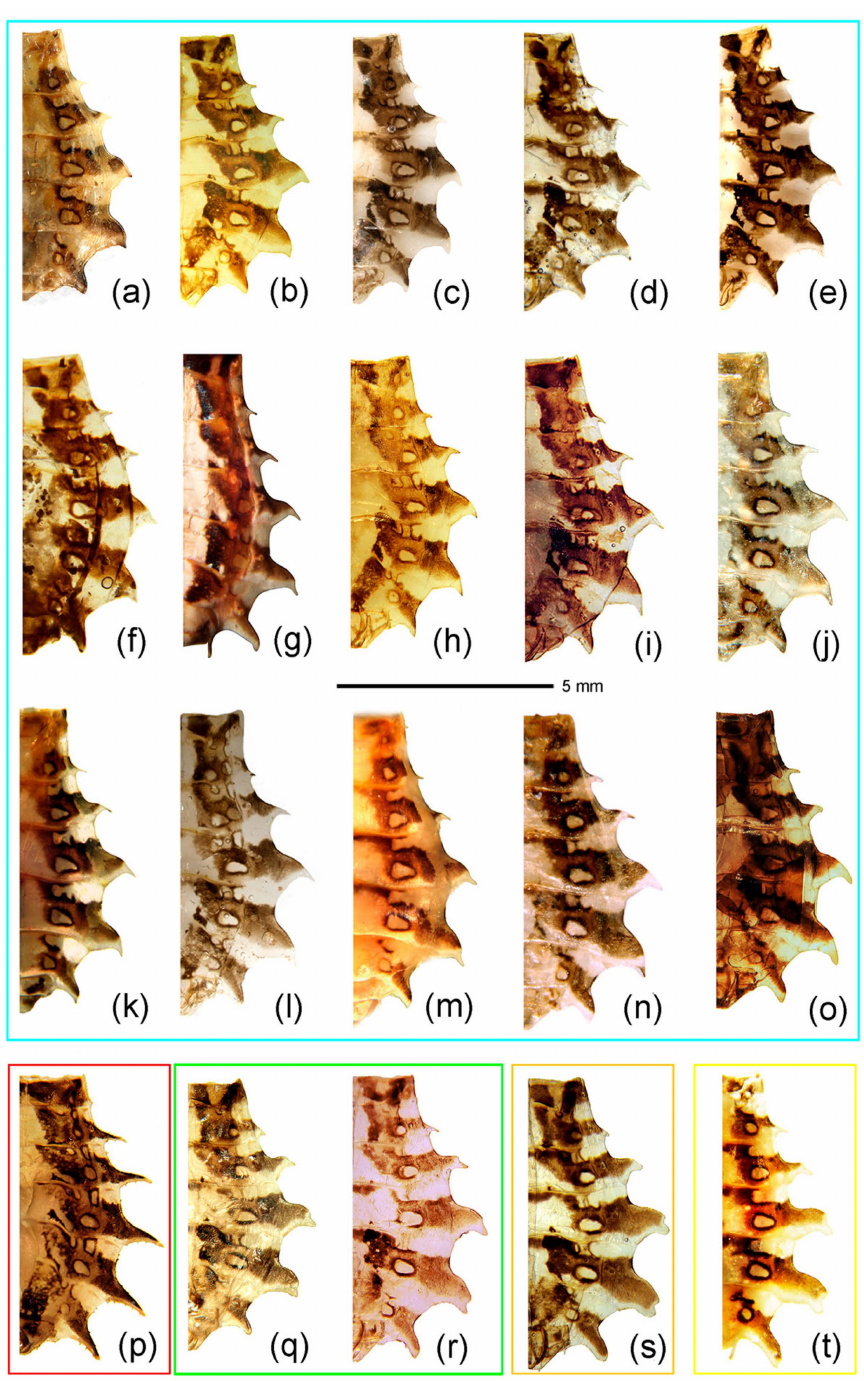
Figure 2. Half of abdomen showing the structural changes in the post-lateral angle of the connexivum. ( a – o ) Sclomina erinacea Stål, 1861; ( p ) Sclomina guangxiensis Ren, 2001; ( q , r ) Sclomina pallens sp. nov.; ( s ) Sclomina xingrensis sp. nov.; ( t ) Sclomina parva sp. nov. ( a ) JXNC; ( b ) JXJG; ( c ) ZJZC; ( d ) FJQZ; ( e ) GDQY; ( f ) AHFY; ( g ) CQSMS; ( h ) GZLP; ( i ) GZLS; ( j ) GDSG; ( k ) GXYL; ( l ) GXJX; ( m ) GZJP; ( n ) TWNT; ( o ) HNBW; ( p ) GXLZ; ( q ) GXTL; ( r ) GZAL; ( s ) GZXR; ( t ) SXYX (for sample codes, see Table A1). Scale bar = 5